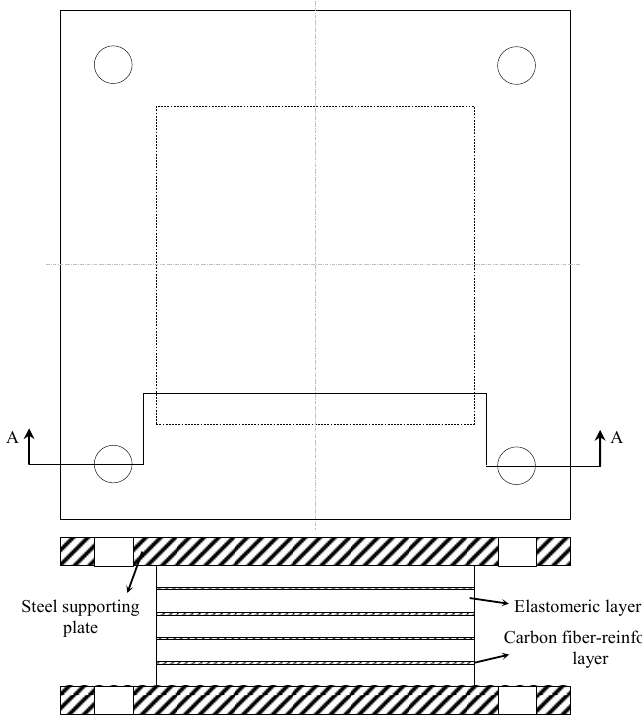
Figure 1. Schematic cross section view of C-FREIs.